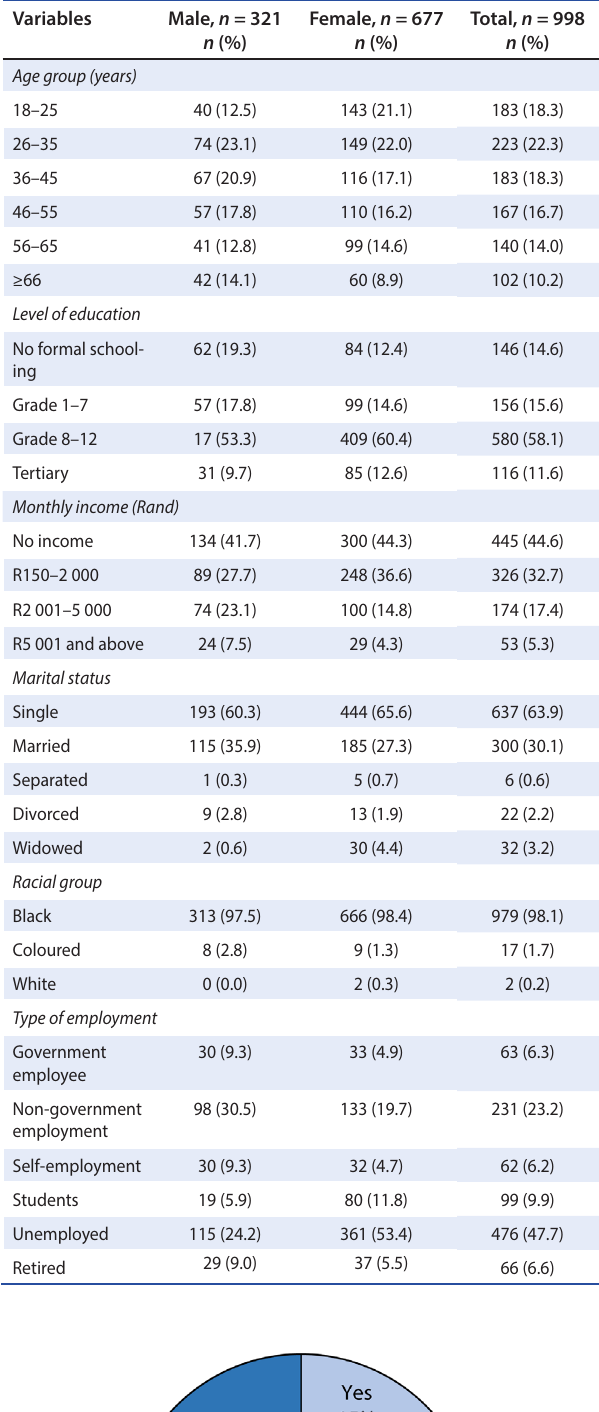
Table 1: Demographic characteristics of the participants by sex Variables